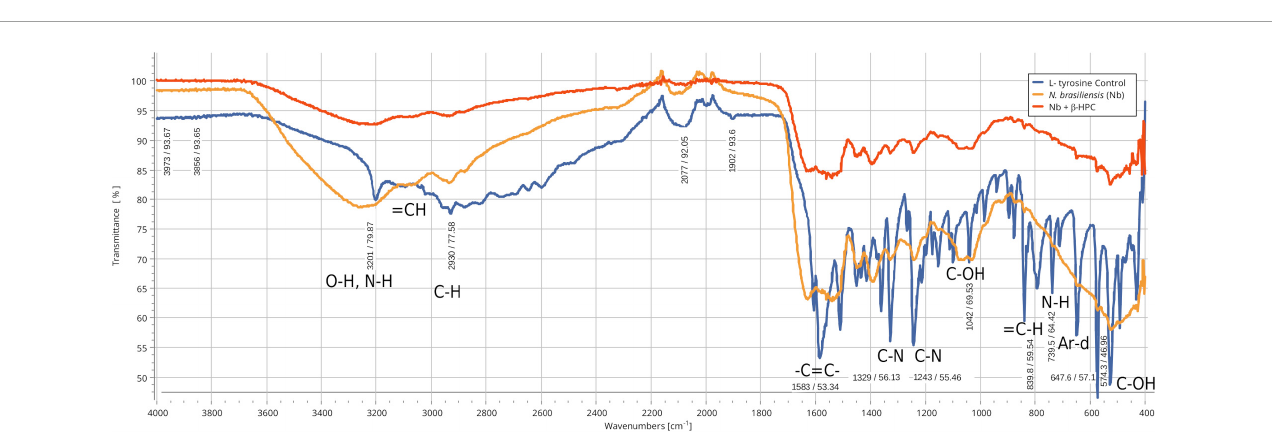
FIGURE3 Comparison of FT-IR spectra of the hydrolytic activity of N. brasiliensis on L-tyrosine with and without β -HFC. Culture medium alone, control (blue line), culture medium with 7 days of growth of N. brasiliensis (orange line), culture medium with 7 days of N. brasiliensis growth + β -HPC (red line). A decrease in the bands corresponding to the functional groups of L-tyrosine is observed with respect to the control when N. brasiliensis is incubated in the culture and the effect is more marked when N. brasiliensis + β -HPC is added since the characteristic signals of this amino acid that correspond to the functional group (OH), to the amino acid (NH), to alkenes ( C = C), and to the aromatic signals (Ar d) notoriously decrease, these signals show a transmittance between 85 and 95 cm − 1 (red line).